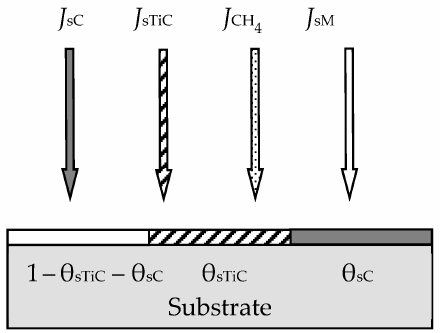
Figure 13. The fl uxes on the substrate surface. Figure 13. The fluxes on the substrate